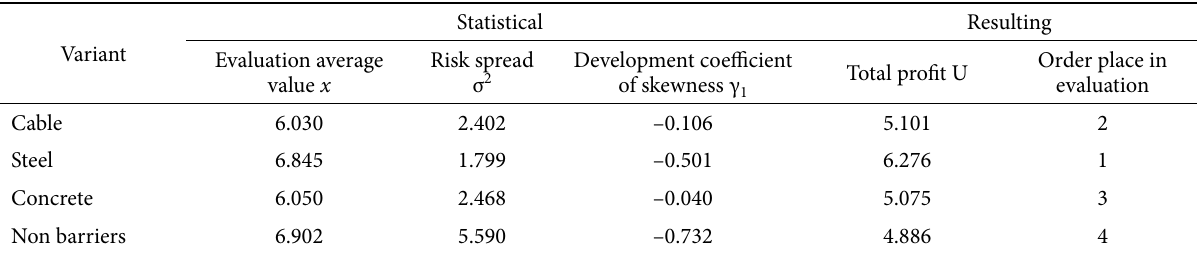
Table 7. Evaluation of individual variants